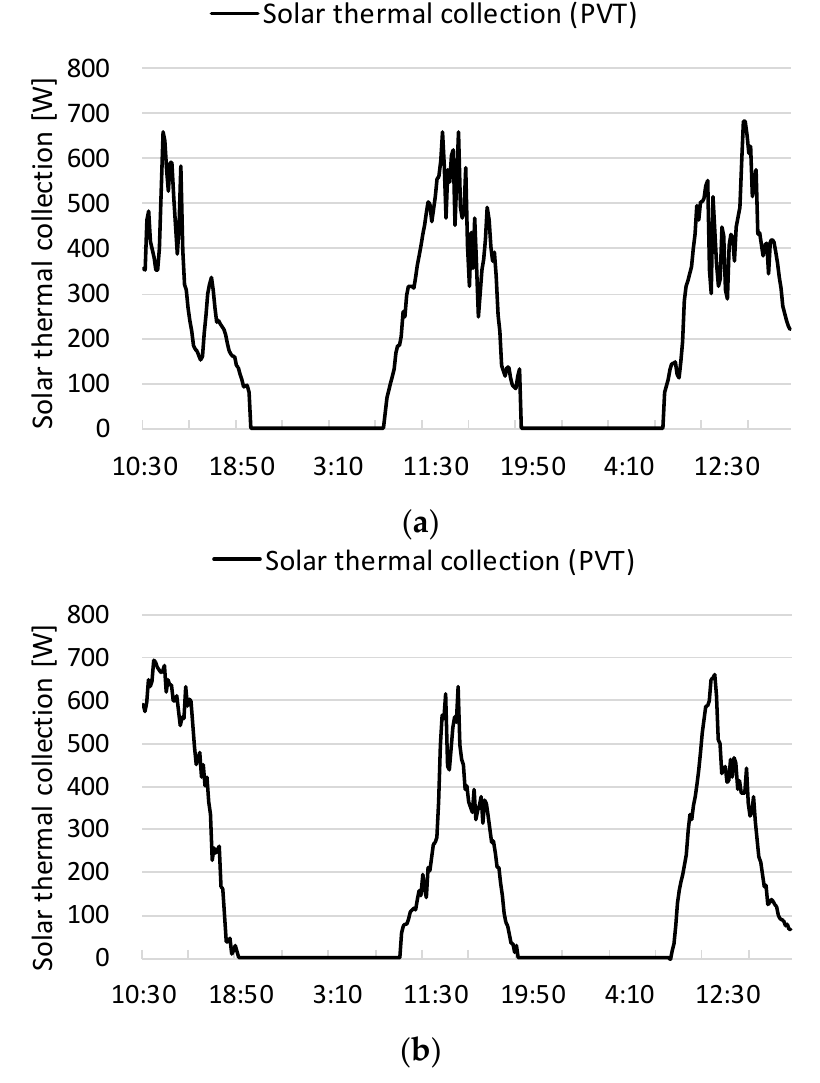
Figure 7. Thermal collection by PVT panel: ( a ) summer; ( b ) winter.